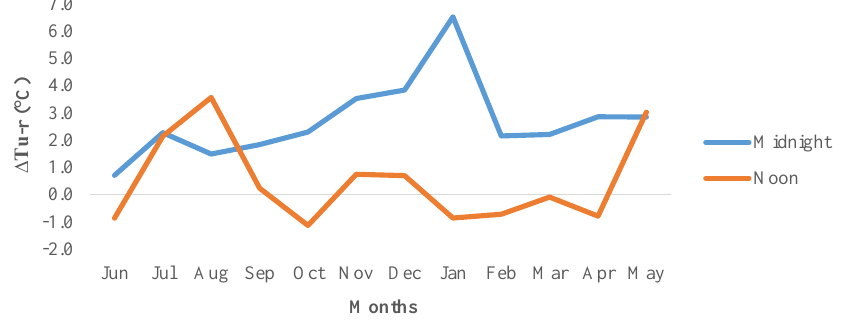
Figure 7. Noon and Midnight Variation of Maximum UHI in Lagos.